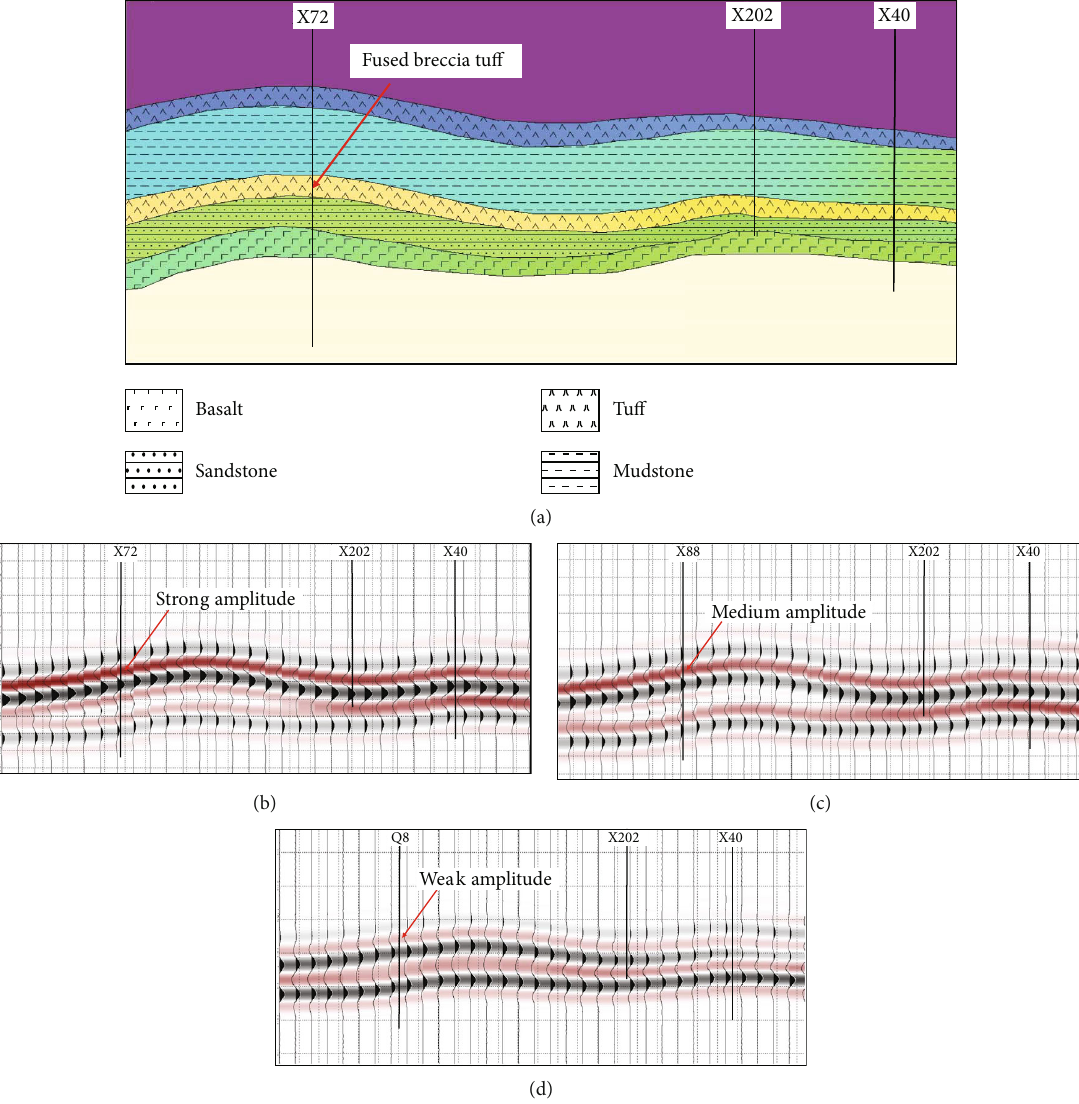
Figure 5: (a) Geological model. (b) Forward modeling migration pro fi le of developed and un fi lled vesicles. (c) Forward modeling migration pro fi le with less developed vesicles or partially fi lled vesicles. (d) Forward modeling migration pro fi le of undeveloped vesicles or fi lled